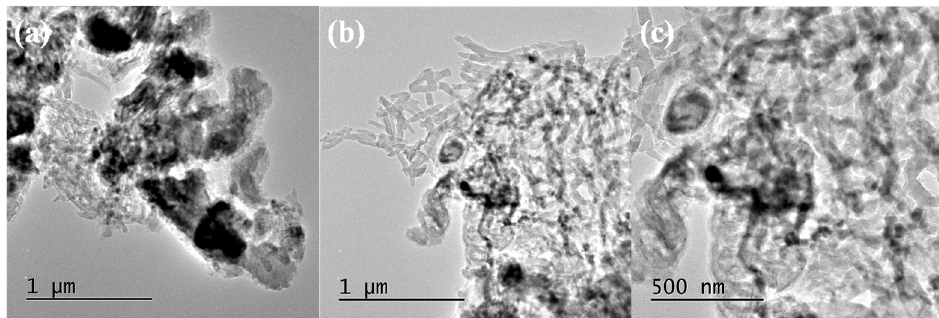
ff erent 3 N 4 ( a – c ) at di